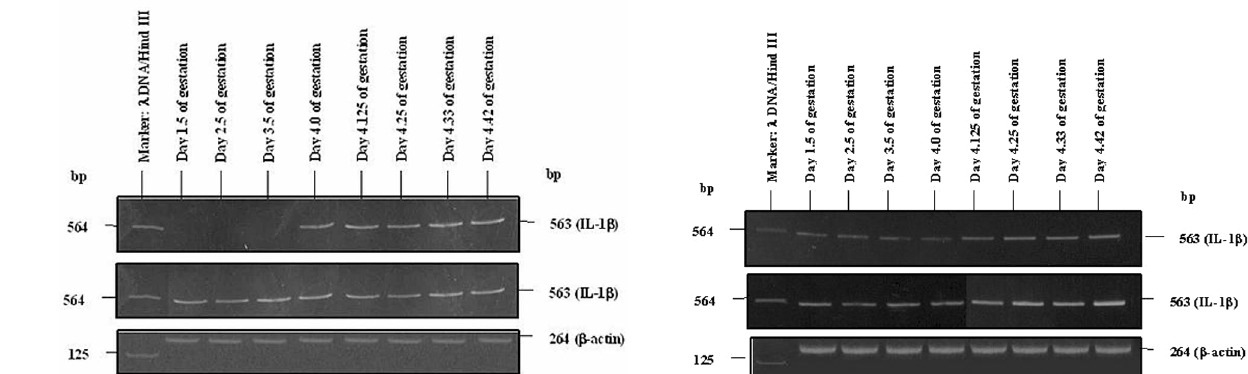
Figure 4. Detection of IL-1 b mRNA transcripts in the uterus of (a) control animals, (b) animals treated with the ‘minimum dose’ of LPS at the different stages of preimplantation period of pregnancy by RT-PCR. Panel (c) shows the expression of b -actin used as a positive